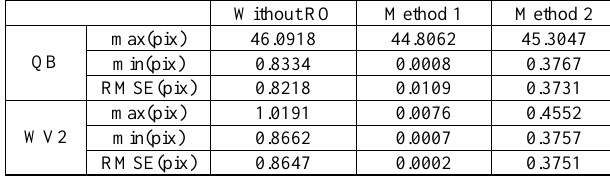
Table 1. Relative pointing errors of QuickBird